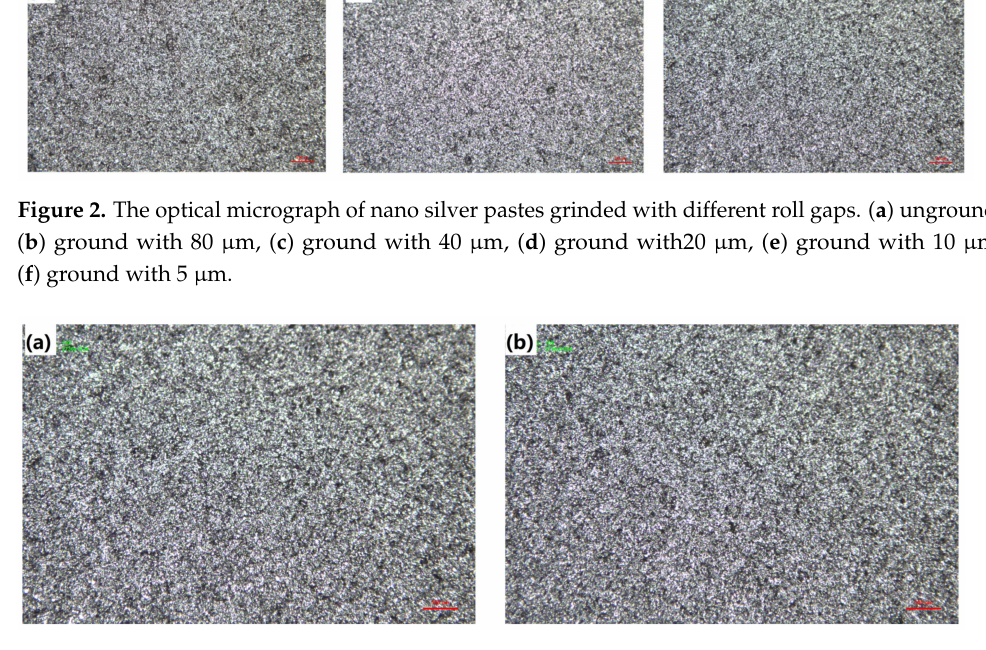
Figure 3. The optical micrograph of nano silver pastes grinded with a roll gap of 5 µ m before ( a ) and after ( b ) static storage 3